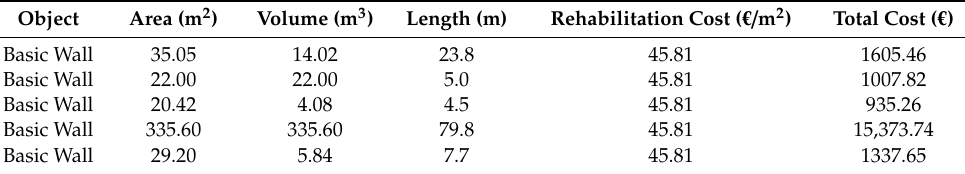
Figure 6. Parameters variations by modeling.